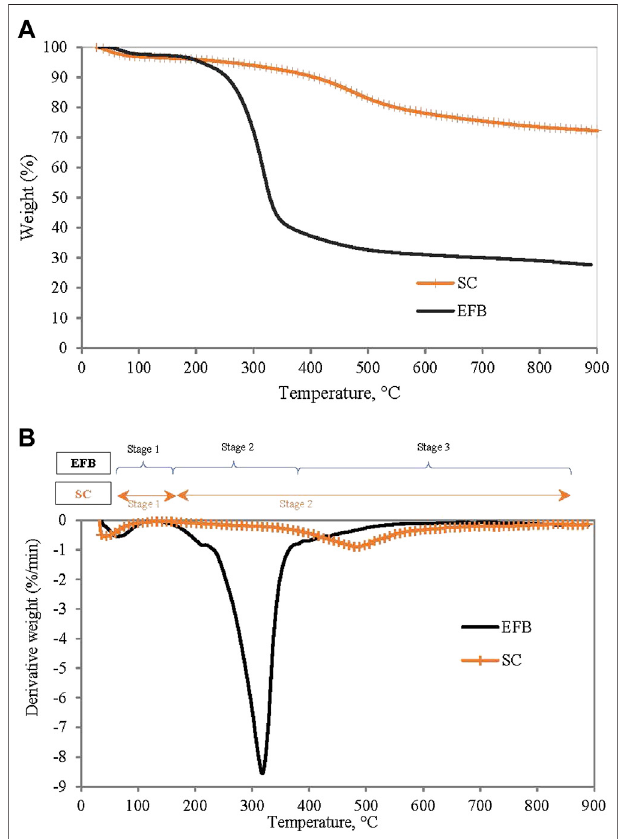
FIGURE 2 | (A) TG curves and (B) DTG curve for Silantek coal and EFB material at heating rate of 10 ° C/min.